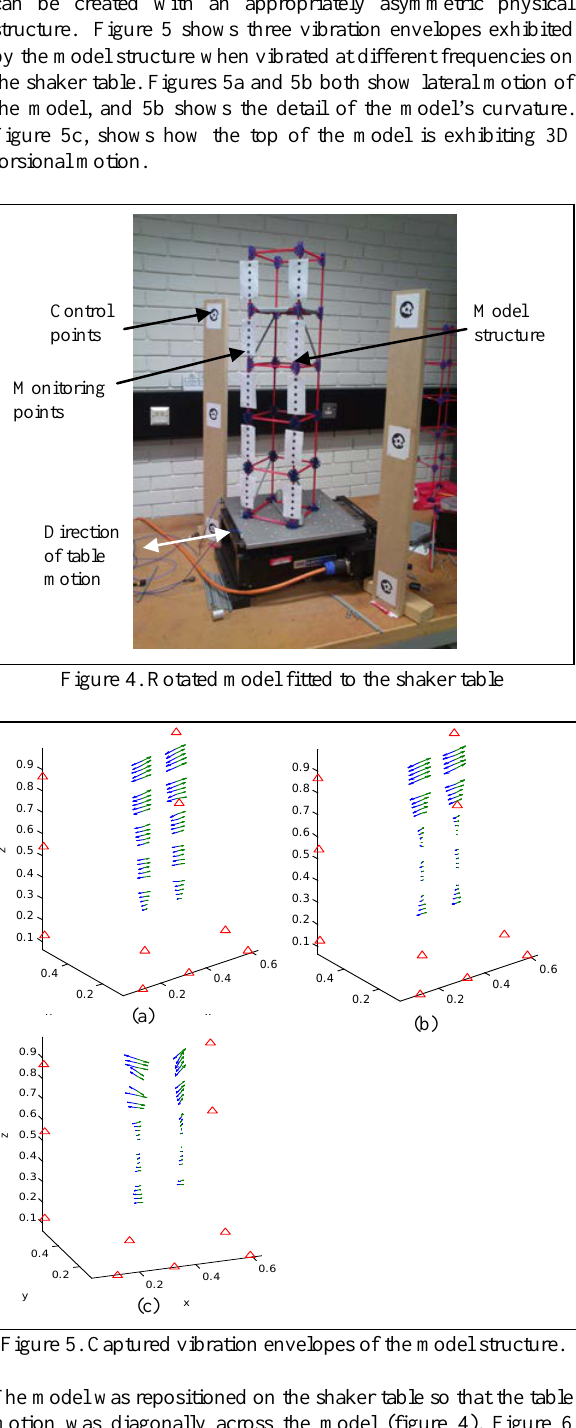
Figure 5. Captured vibration envelopes of the model structure.